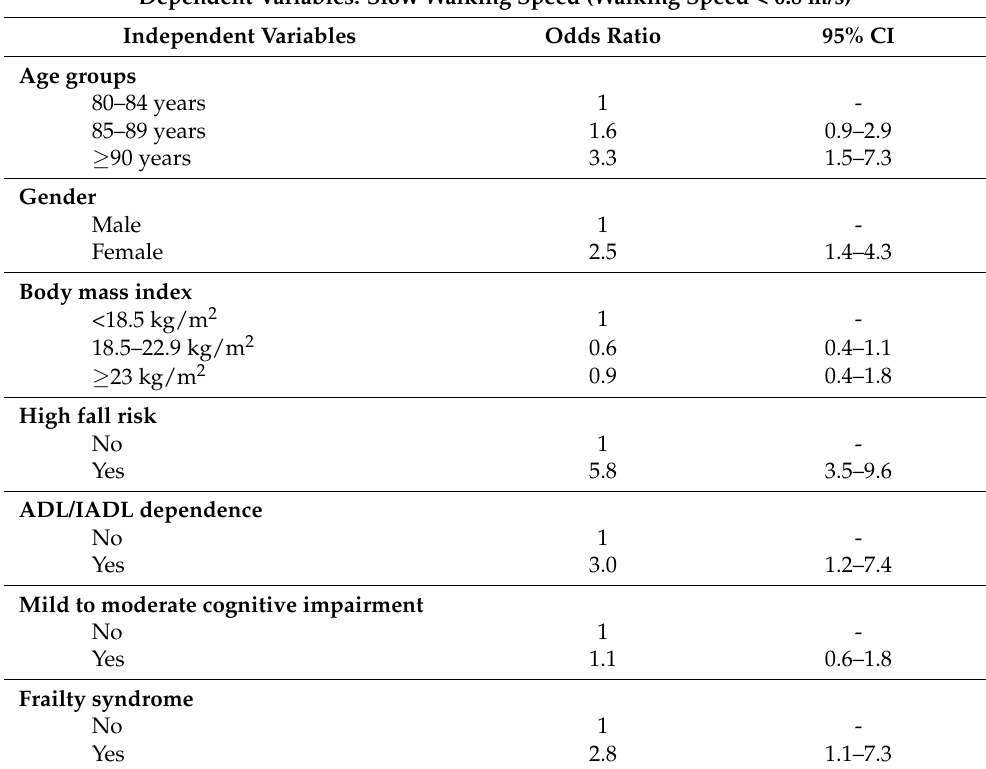
Table 4. Multiple logistic regression analyses of the association between a slow walking speed and selected